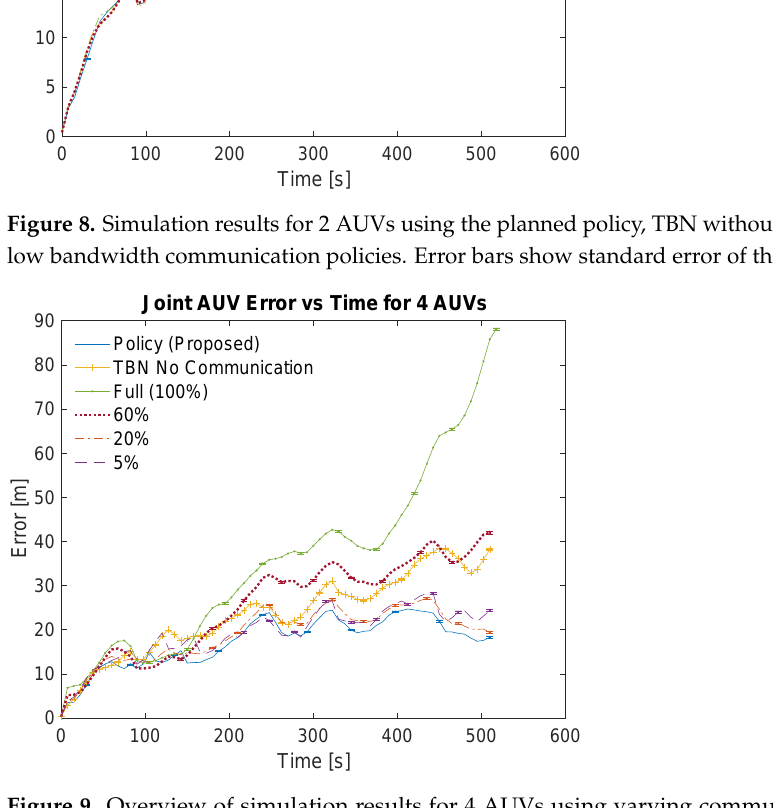
Figure 9. Overview of simulation results for 4 AUVs using varying communication bandwidths. Error bars show standard error of the mean.